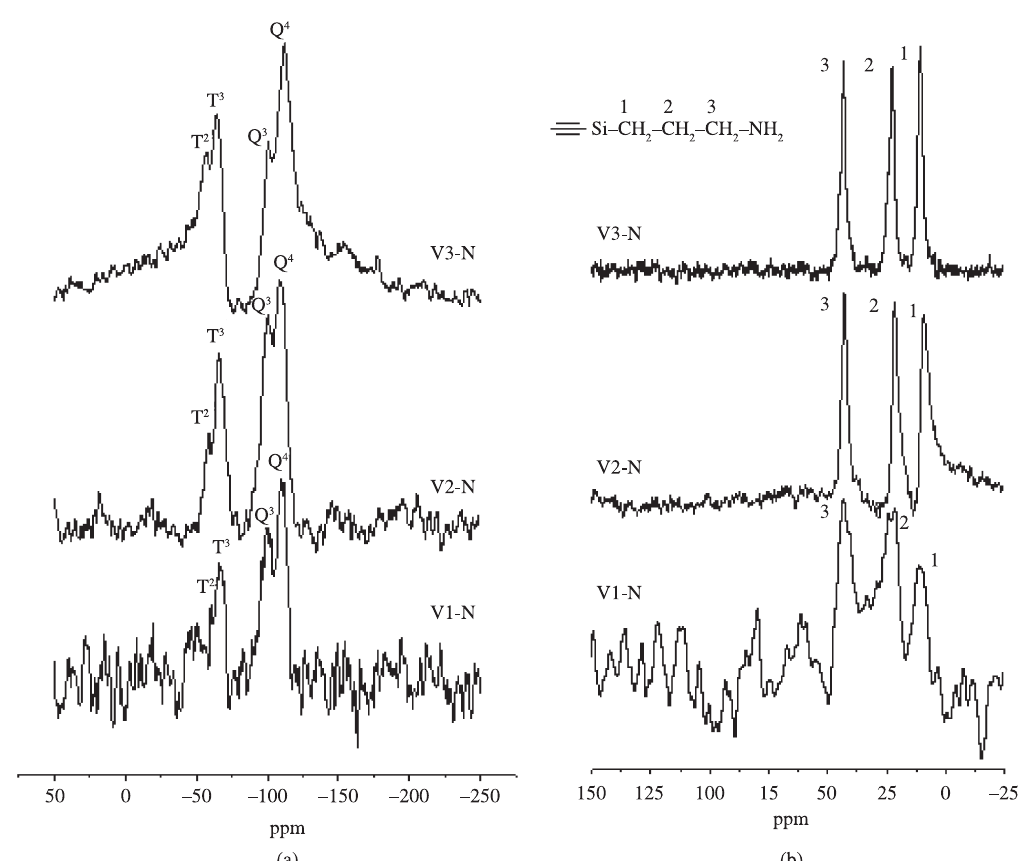
Figure 5. Si 29 (a) and C 13 NMR spectra (b) for Vm-N (m = 1, 2, 3)